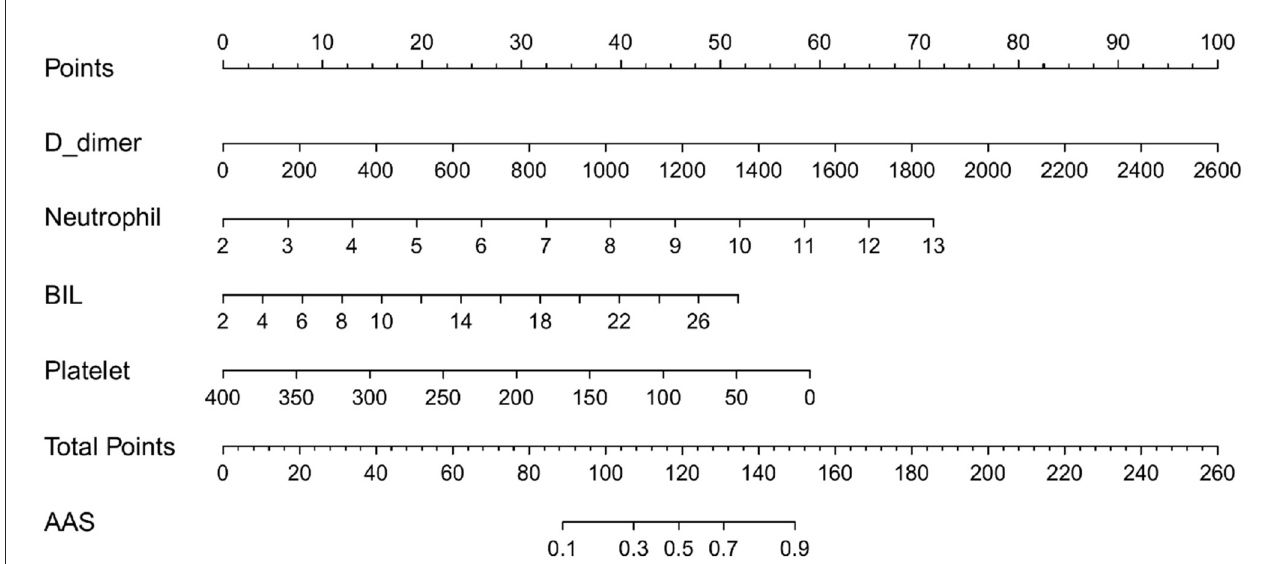
FIGURE4 The nomogram model used for discriminating AAS from NSTEMI with chest pain onset at ≥ 2h. D-dimer/(ng/mL) > 2,520 calculated as 2,520; neutrophil/(10 ∧ 9/L) > 13 calculated as 13; BIL/(U/L) > 27.6 calculated as 27.6. AAS, acute aortic syndrome; BIL, bilirubin; NSTEMI, non-S T- elevation myocardial infarction.